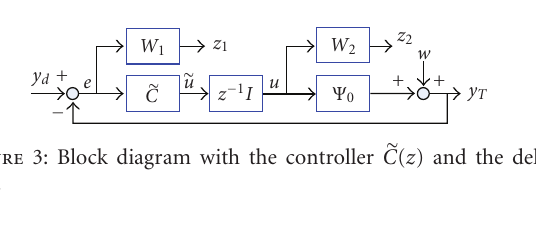
Figure 2: Frequency response magnitude of W − 1 parameters.